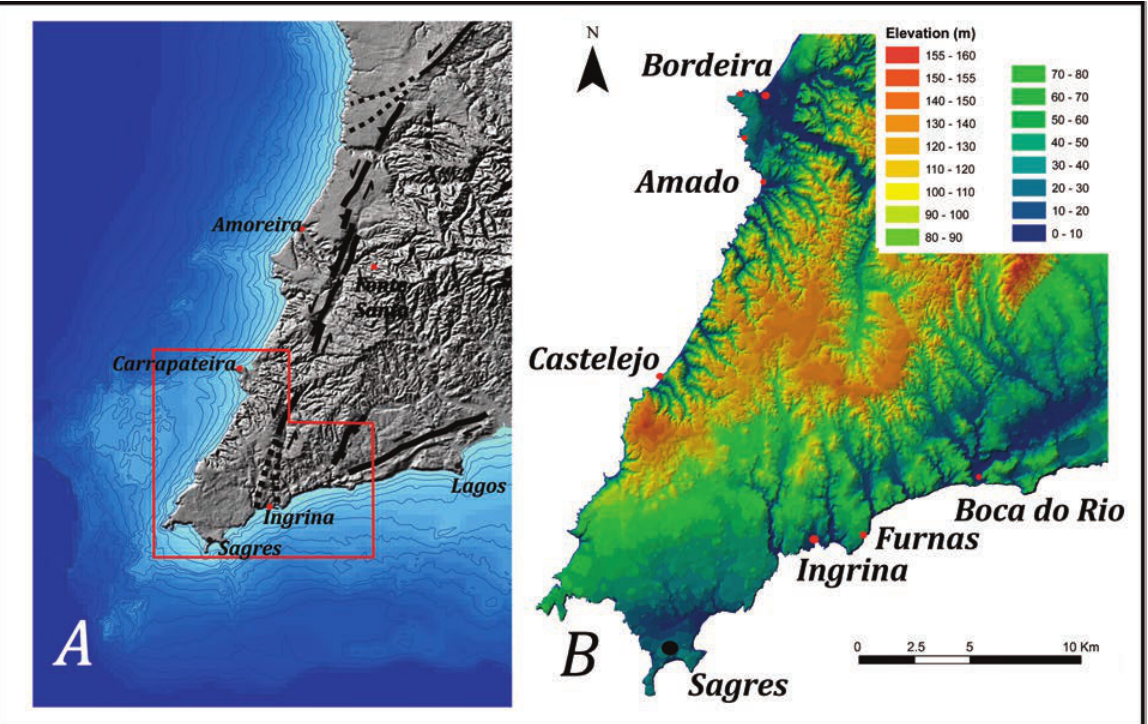
Figure 2. Digital terrain model of southwestern Portugal: (A): Regional Geomorphology with main active structures Shaded relief (SRTM) and continental shelf bathymetry (0 to 200 m depth, contour lines, each 10 m (IH); (B) Digital Terrain Model from the study area, (IGEOE topographic data). Red dots indicate marine terrace locations, black dots correspond to